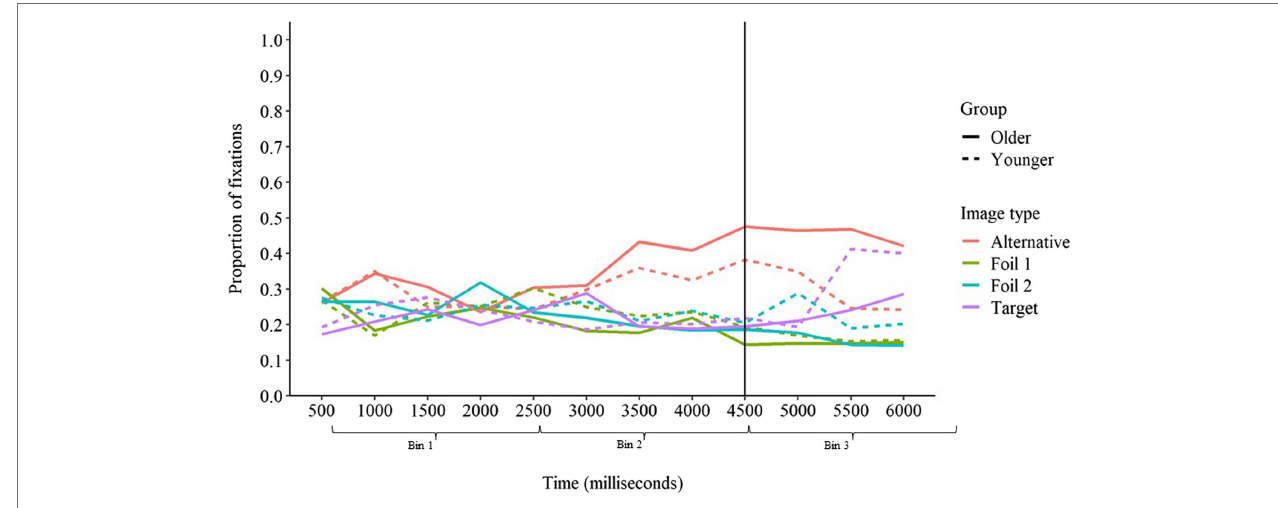
FIGURE 6 | Proportion of fixations on each image type over time in incongruent sentences for younger and older adults. The vertical line at 4,500 ms represents the onset of the target